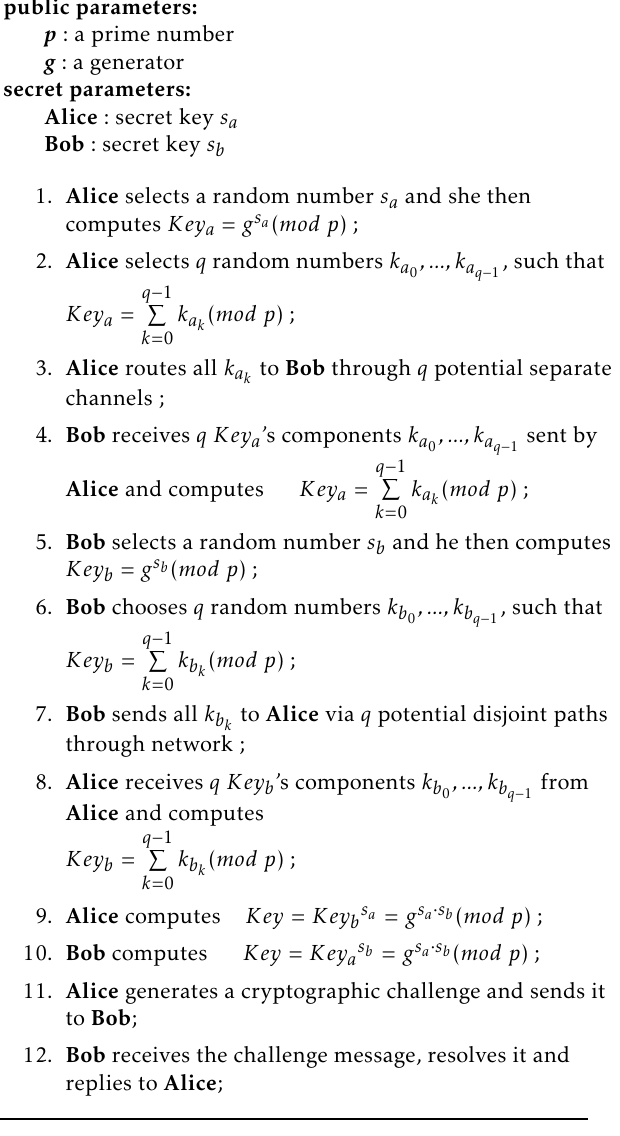
Figure 4. Data owned and actions performed by the source and destination nodes to negotiate the keys. Illustration of Algorithm 3. node represents an edge of the graph and each link Algorithm 3: Multipath key exchange indicates a connection between two nodes.